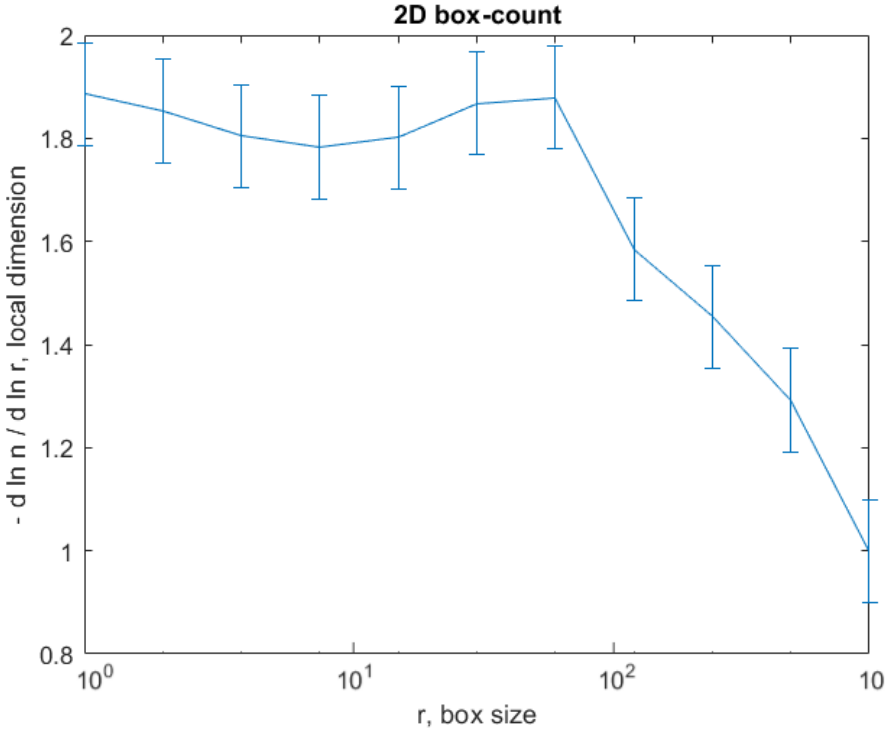
Figure 16. Box-count algorithm results: fractal dimension.